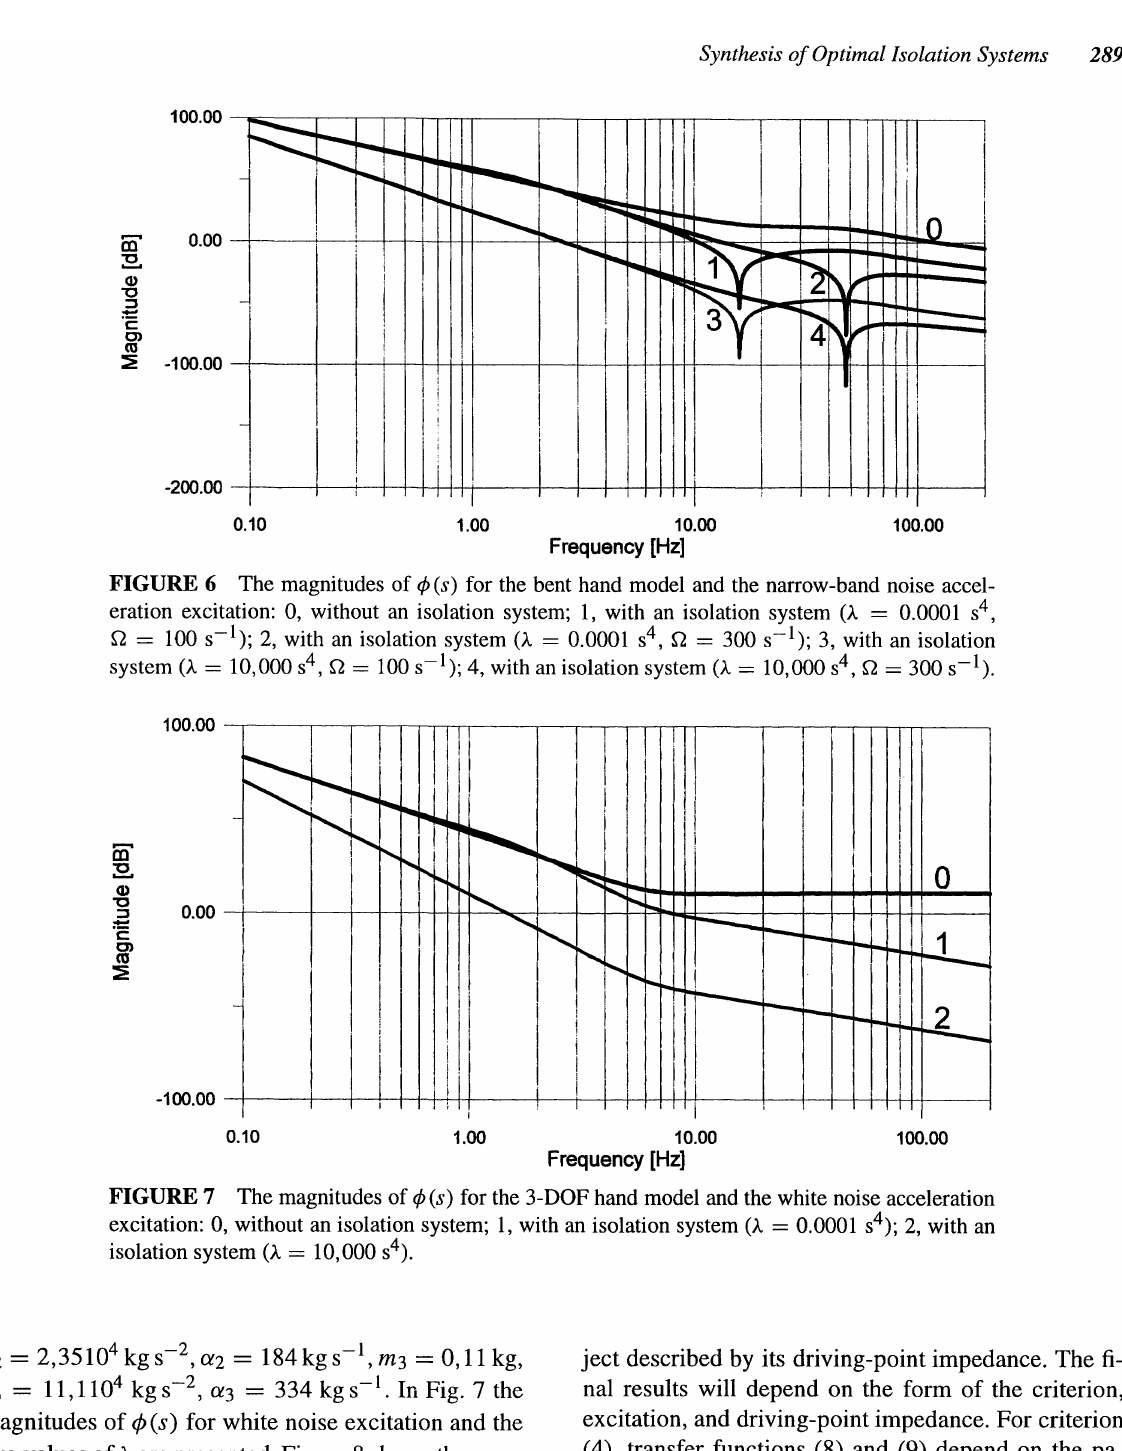
FIGURE 7 The magnitudes of <p(s) for the 3-DOF hand model and the white noise acceleration excitation: 0, without an isolation system; 1, with an isolation system (). = 0.0001 s4); 2, with an isolation system (J. = 10,000